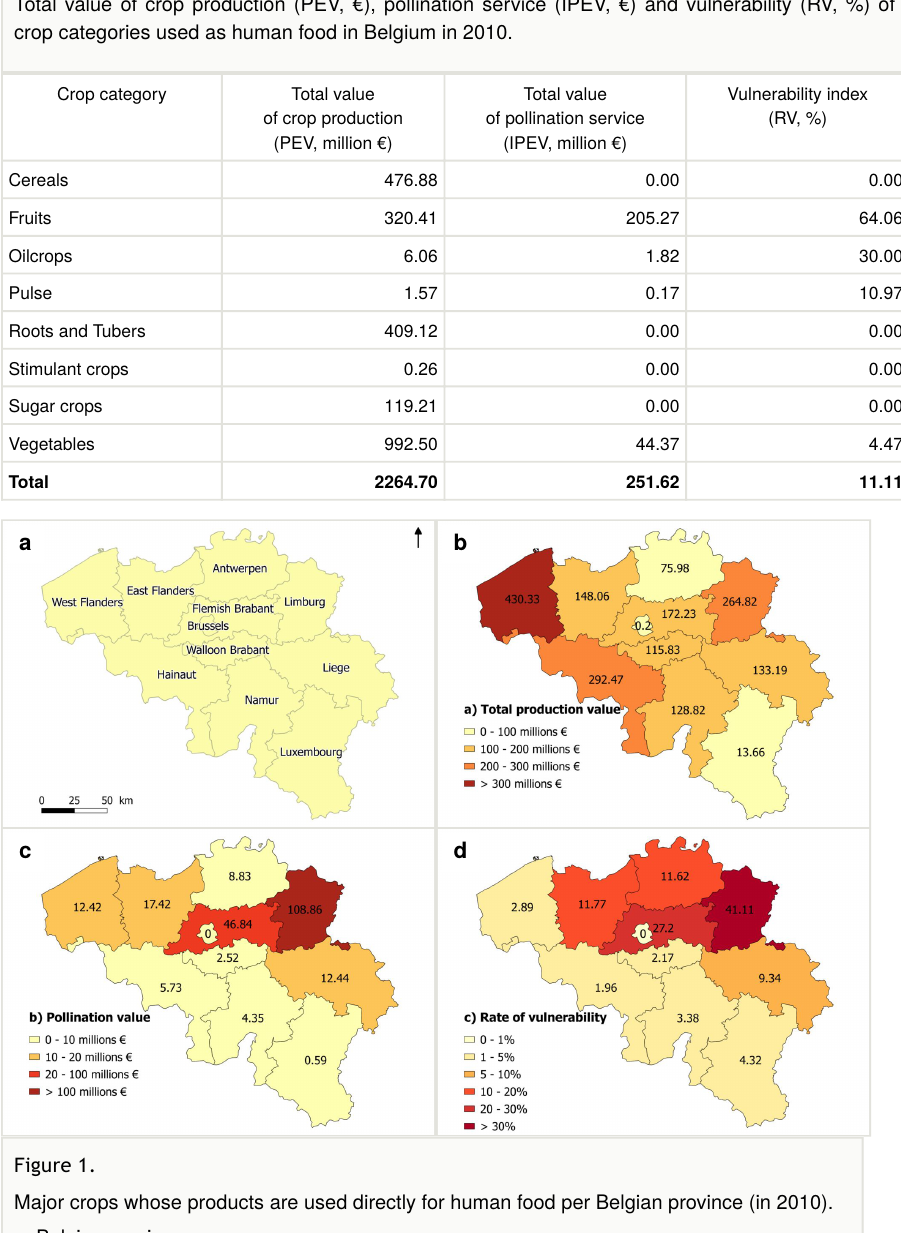
Major crops whose products are used directly for human food per Belgian province (in